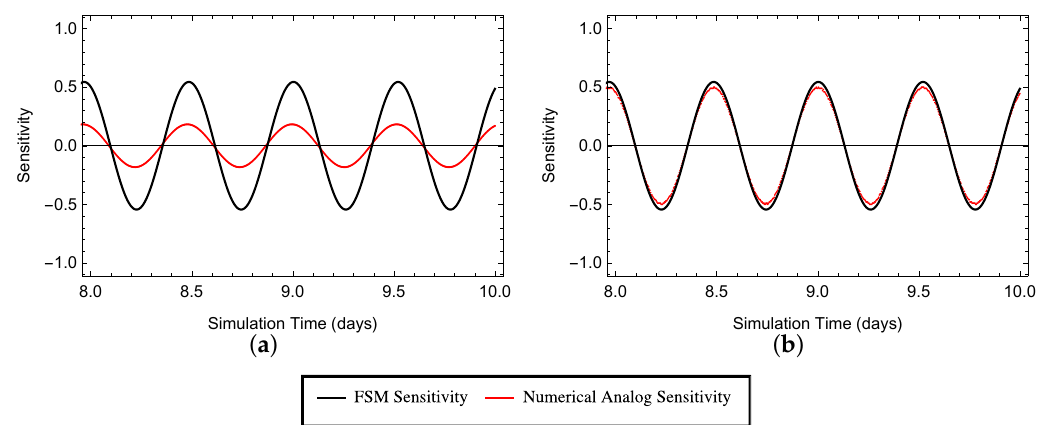
Figure 6. Comparison of forward sensitivity method and numerical analog elevation sensitivity results for the last two days of an explicit model simulation on the linear sloping domain. In each panel, the black line depicts the temporal evolution to the FSM elevation sensitivity to G for a simulation with G = 0.001 s − 1 . The red line shows the time series of the numerical analog sensitivities. In the left panel, the two G values used for the simulations were 0.001 and 0.003 s − 1 , while G values of 0.001 and 0.0011 s − 1 were used to generate the numerical analog for the right panel. ( a ) ∆ G = 0.002 s − 1 ; ( b ) ∆ G = 0.0001 s − 1